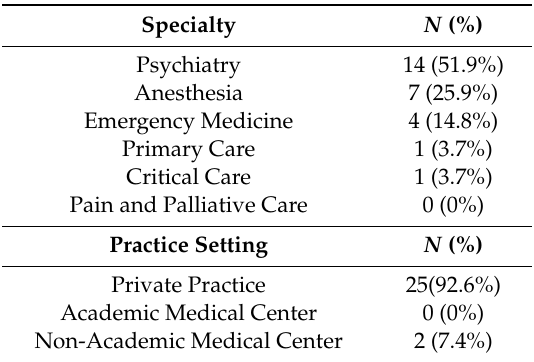
Table 1. Demographics of Survey Respondents.